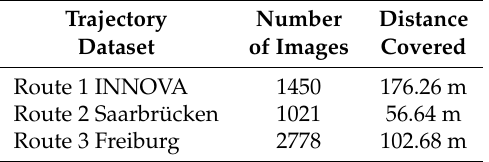
Table 1. Distance covered [m] and number of images used for each of the